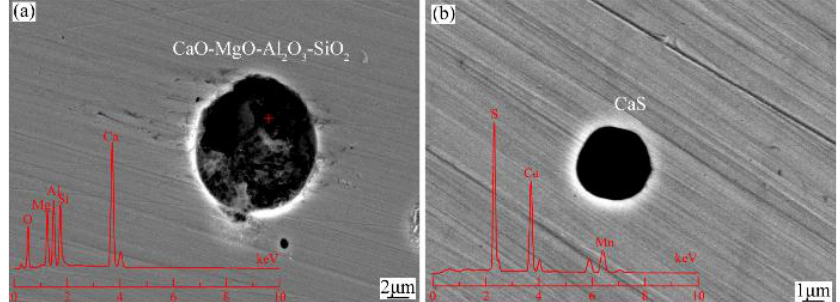
Figure 6. Compositions and morphologies of typical inclusions after soft blowing, ( a ) CaO-MgO- Al 2 O 3 -SiO 2 composite inclusion, ( b ) CaS.